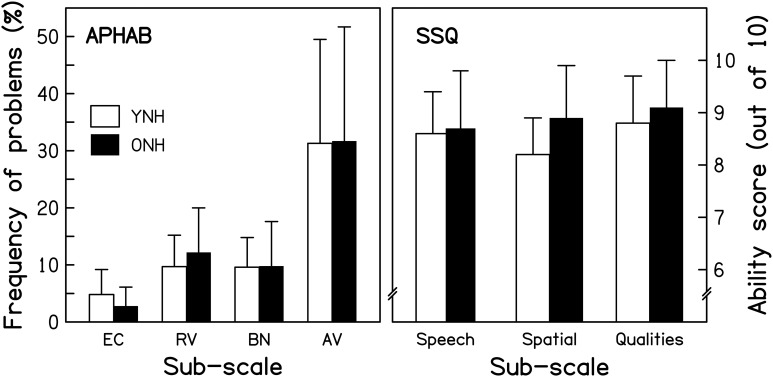
Scores for the YNH (open bars) and ONH (filled bars) participants for two questionnaires. For the Abbreviated Profile of Hearing Aid Benefit (APHAB; left panel), responses in terms of frequency of experiencing the described problems are averaged for each of four sub-categories: Ease of communication (EC), Reverberation (RV), Background noise (BN), and Aversiveness (AV). For the Speech, Spatial, and Qualities of hearing scale (SSQ; right panel), responses on an 11-point scale (0–10, with greater scores reflecting less disability) are averaged for the sub-categories of Speech hearing (14 questions), Spatial hearing (17 questions), and Qualities of hearing (19 questions). Note that more hearing difficulties are indicated by taller and smaller bars in the left and right panels, respectively.